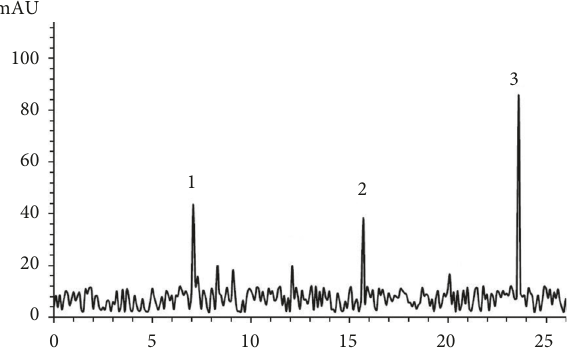
Figure 1: LC-MS analysis of the Atrifil extract and Oshagh gum. 3 flavonoids were detected by LC-MS.